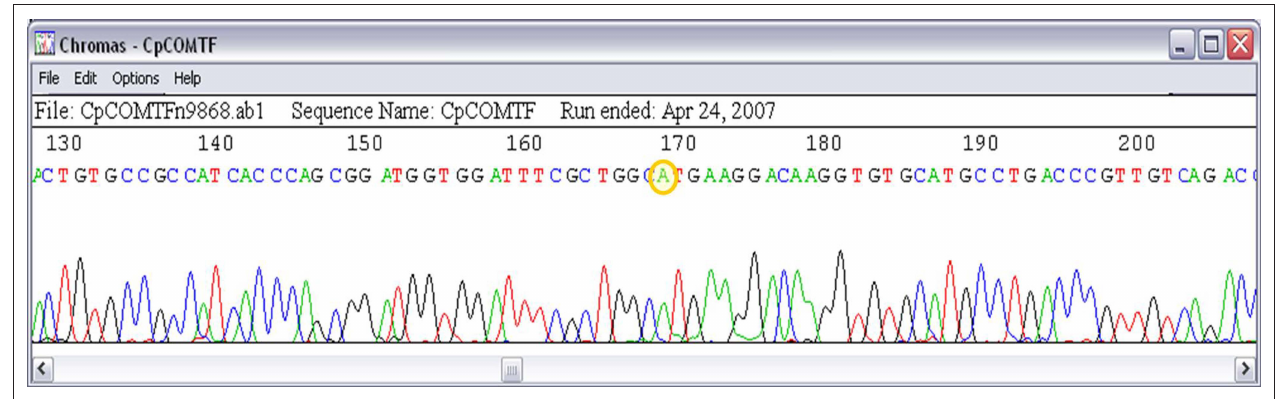
FIguRe 4 | electropherogram showing the genotype a/a (yellow circle) of CoMT-rs4680 polymorphism.